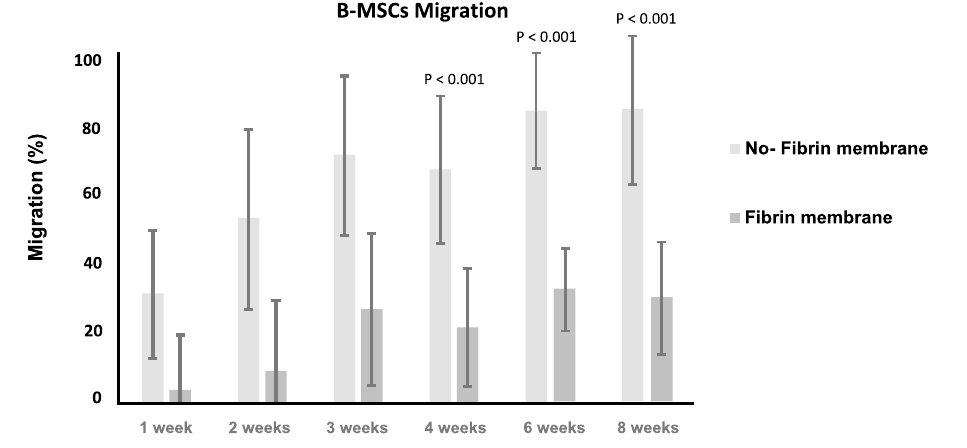
Figure 3. B-MSCs migration within the membrane.